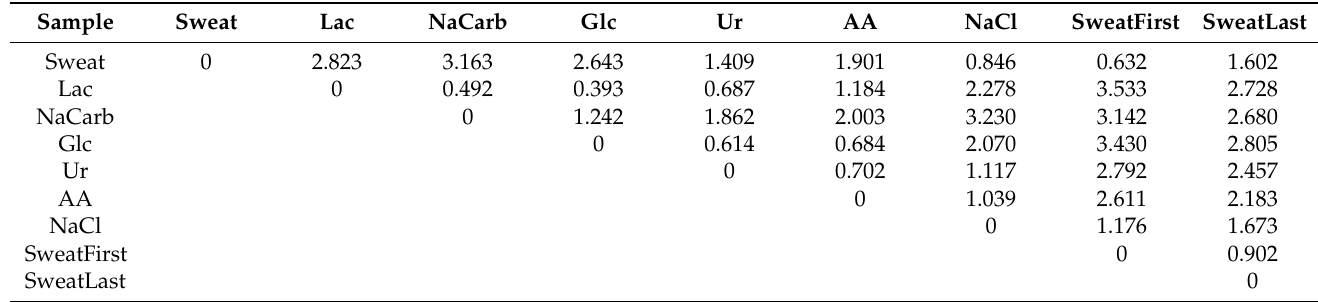
Table 3. Euclidean distance between each of the first repeat measurements of the different samples, based on the 5 extracted PCs using the results obtained from the wearable